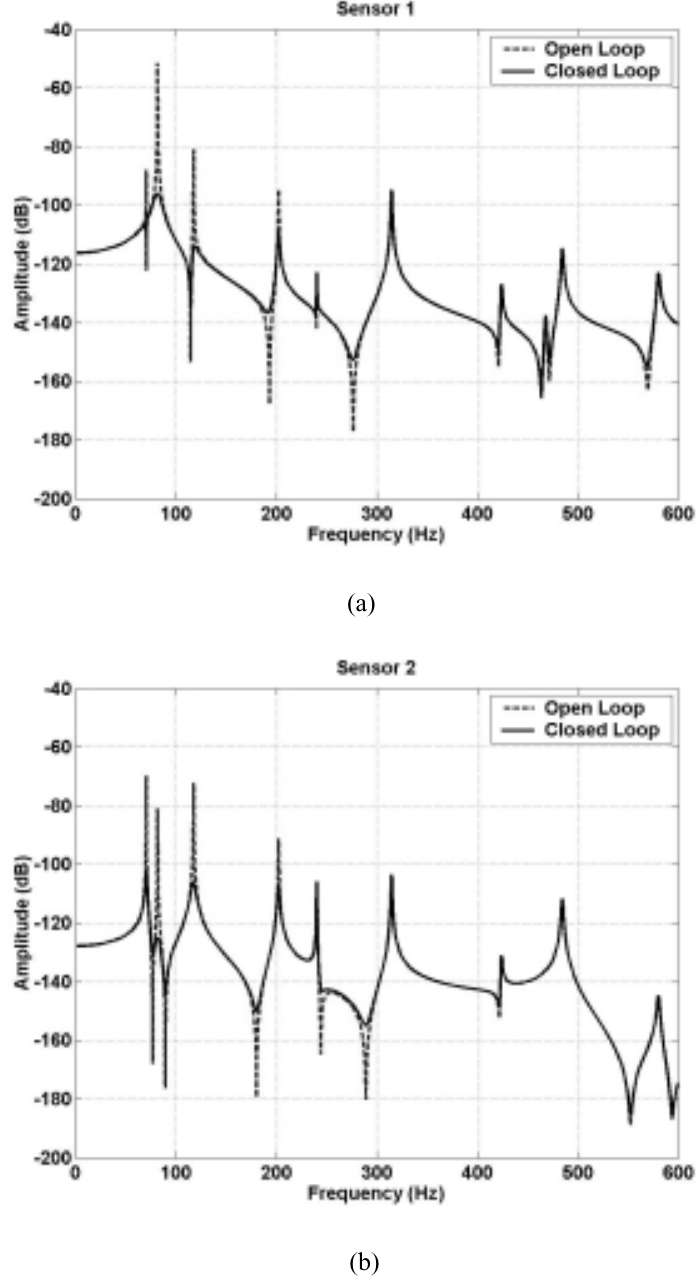
Fig. 6. Spectra of the uncontrolled and controlled system at (a) sensor 1 and (b) sensor 2 when the IMSC strategy is implemented. modes) if the IMSC algorithm is used to design a control system for a multi-degree-of-freedom structural system. Thus, the effects of control forces on higher modes must be considered in the response